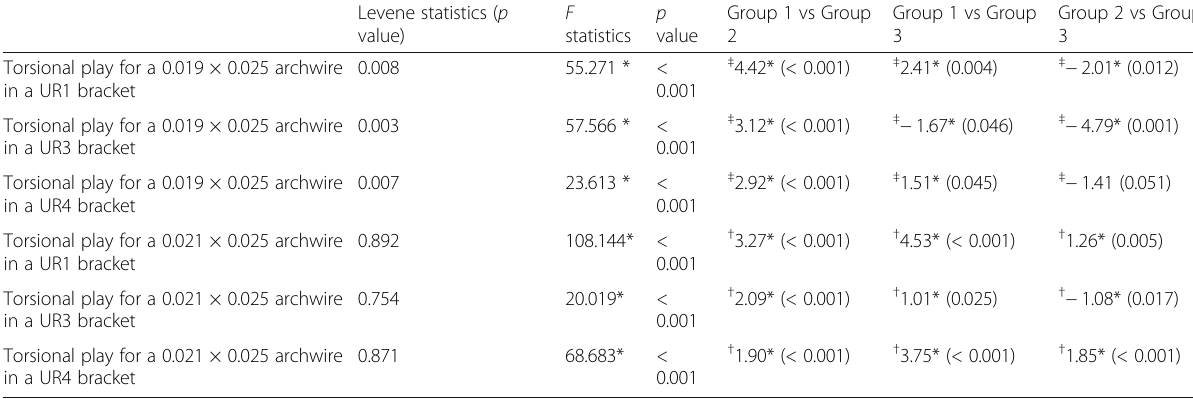
Table 7 Results of one-way ANOVA comparing the values of torsional play between different